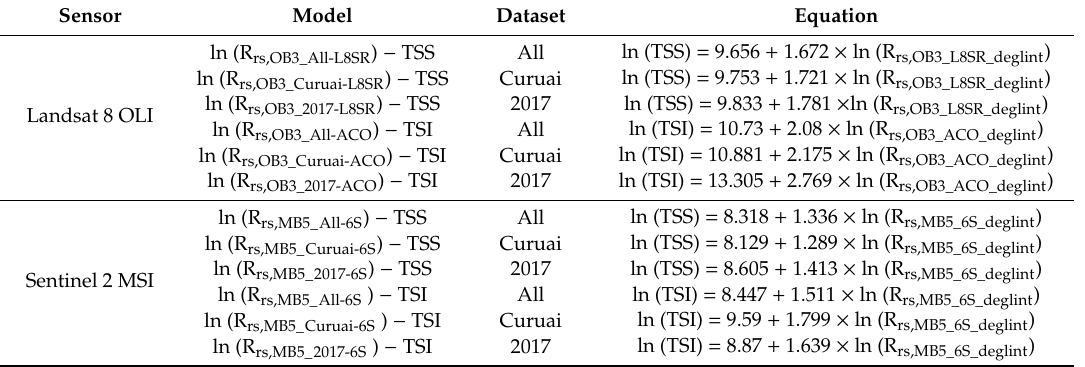
Table 6. The equations used for model validation in OLI and MSI imagery: All is All Dataset; Curuai is Lake Model for Curuai Lake between 2015–2017; 2017 is Campaign Dataset for 2017 campaign. The subscripts in the model column refers to the model used (All, 2017, or Curuai), and the atmospheric correction method, as well TSS and TSI, refer to the type of